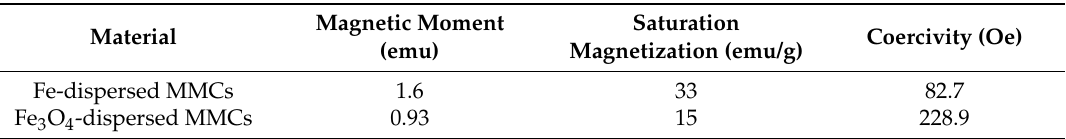
Table 1. The measured magnetic properties for the Fe and Fe 3 O 4 metal matrix composites nugget zone after triple friction stir processing (FSP)